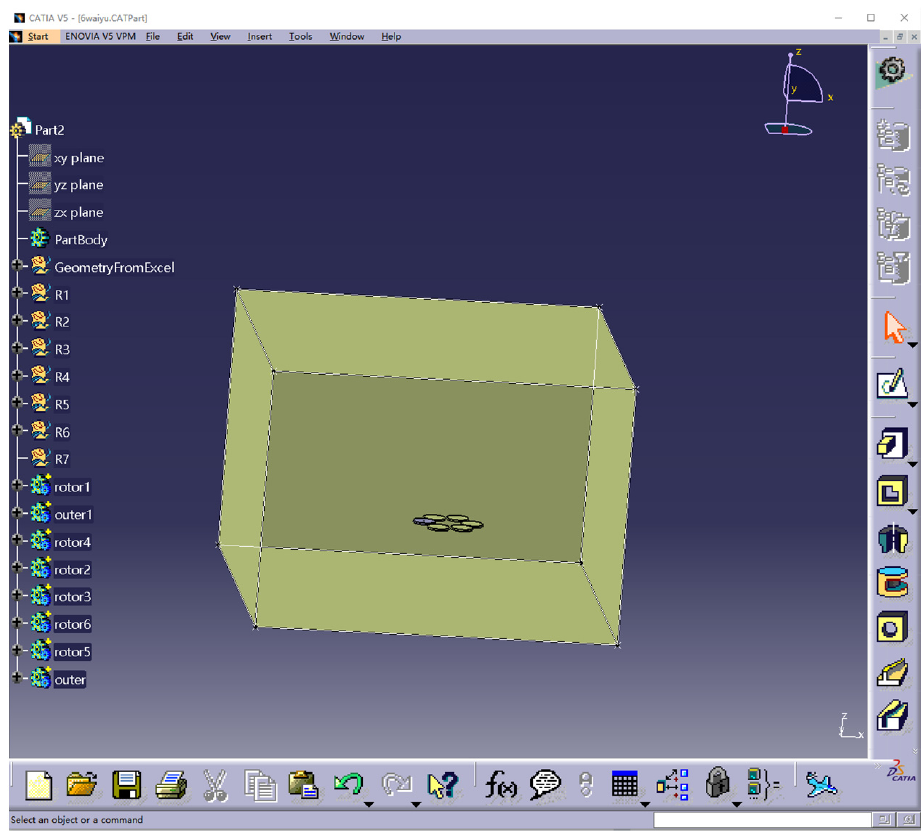
Figure 5. Physical model of external regions.